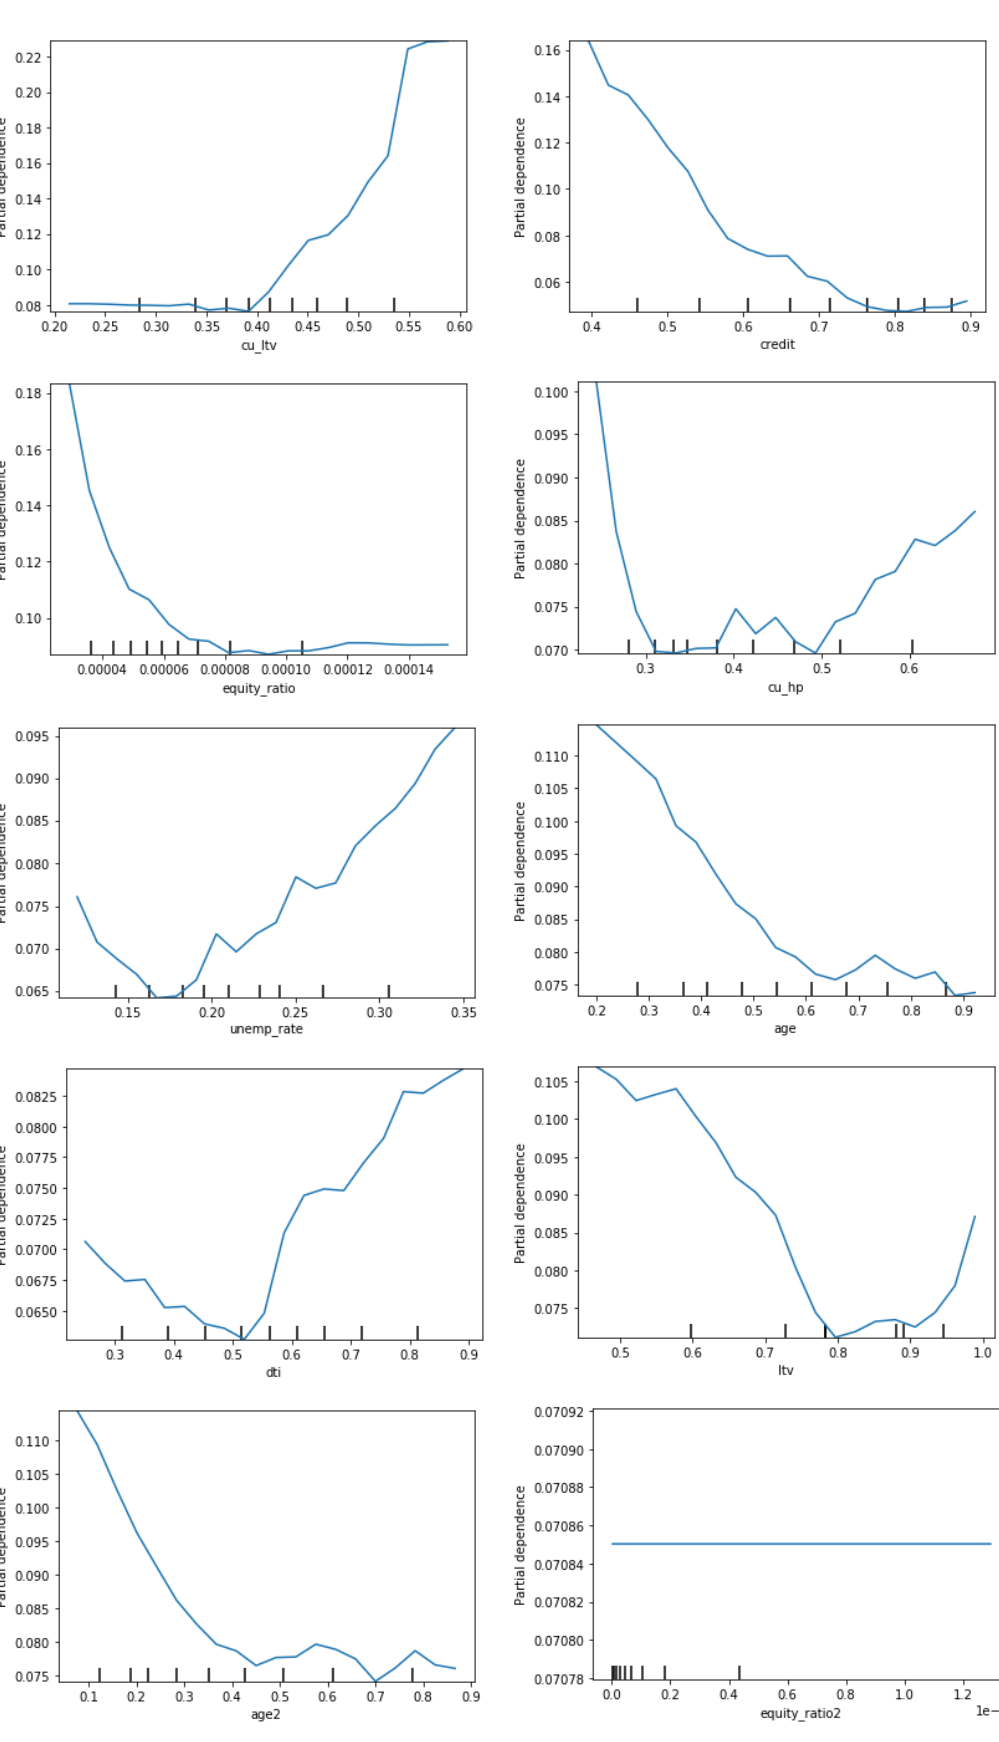
Figure 6. PDP of the RF